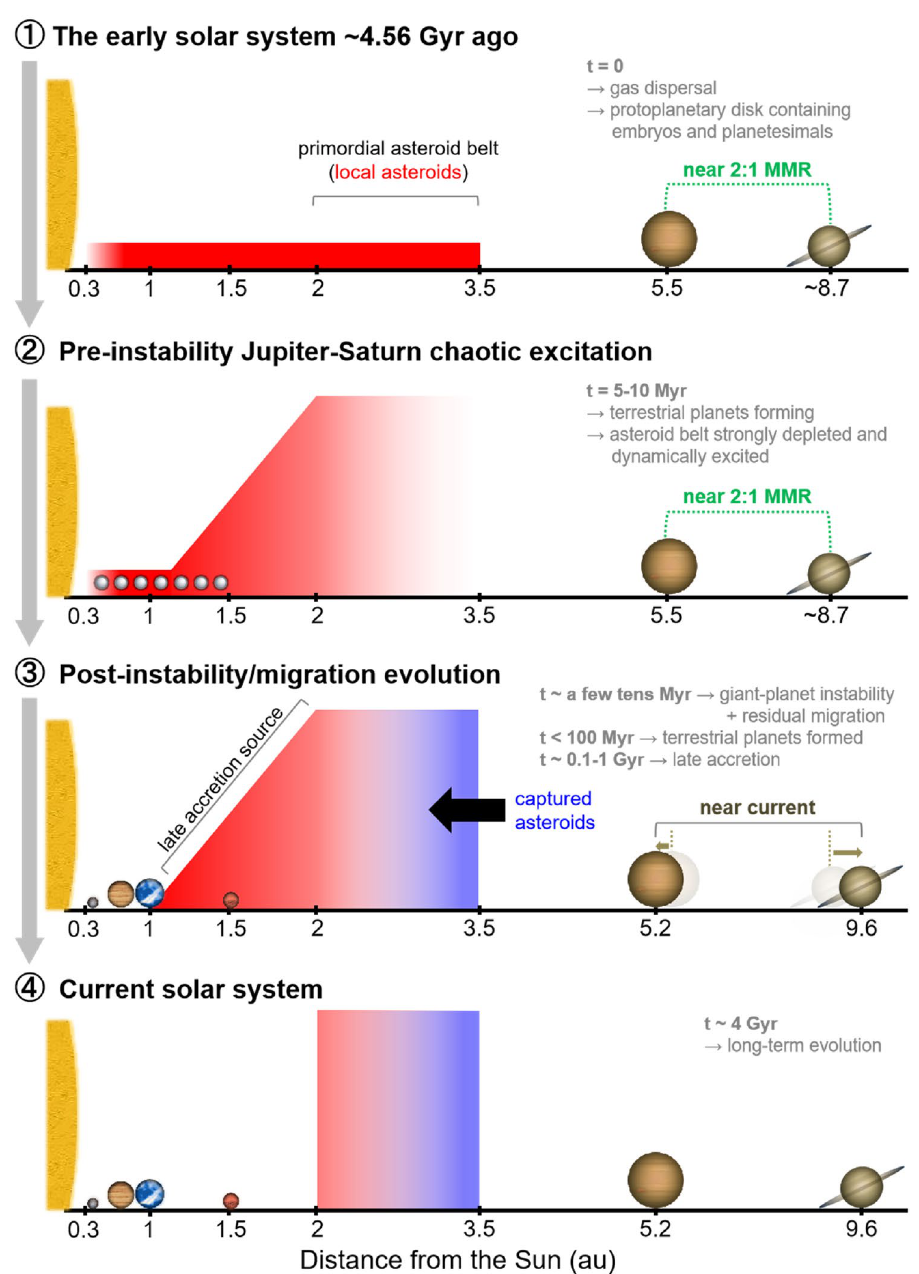
Figure 1. Outline of the Jupiter–Saturn chaotic excitation scenario for the formation of the terrestrial planets and the asteroid belt. Four main stages describe the dynamical history of the solar system. The approximate duration of key events is denominated by t . See the main text and Supplementary Information for the